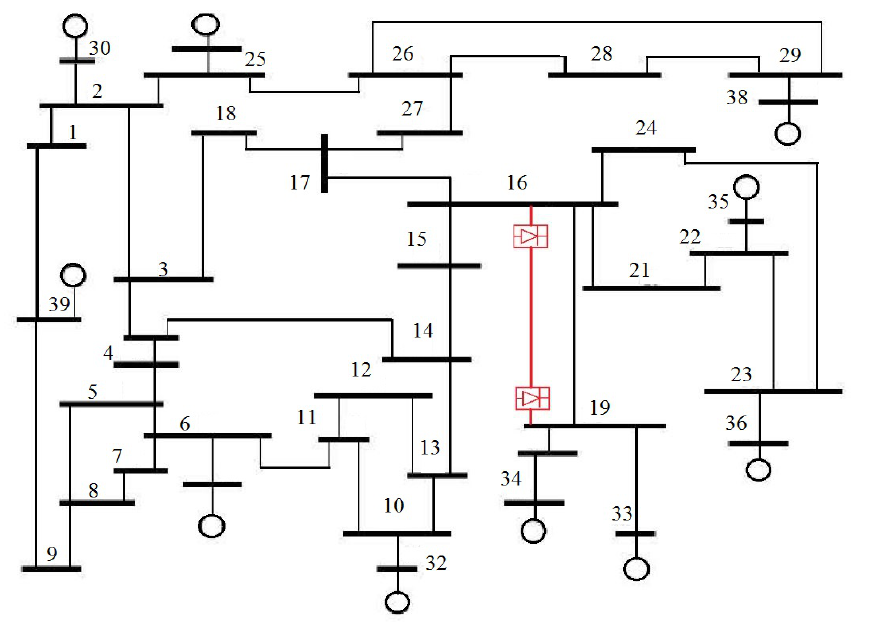
Figure 5. Modified New England IEEE 39-Bus system with HVDC link.